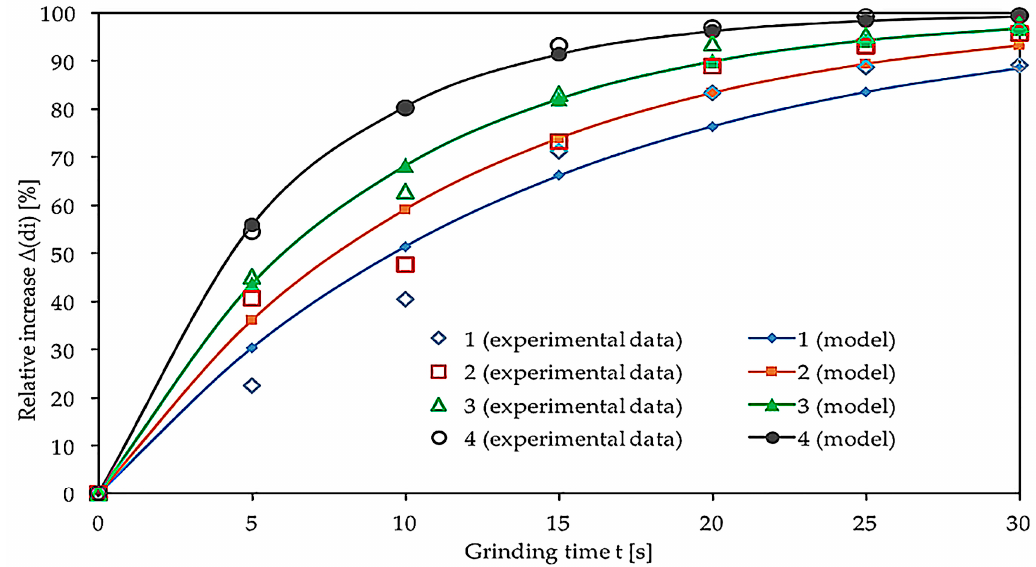
Figure 4. Curves of the relative increment of the 0–0.04 mm particle size fraction in the comminution product for the investigated grinding media characteristics. Appl. Sci. 2018 , 8 , x FOR PEER REVIEW